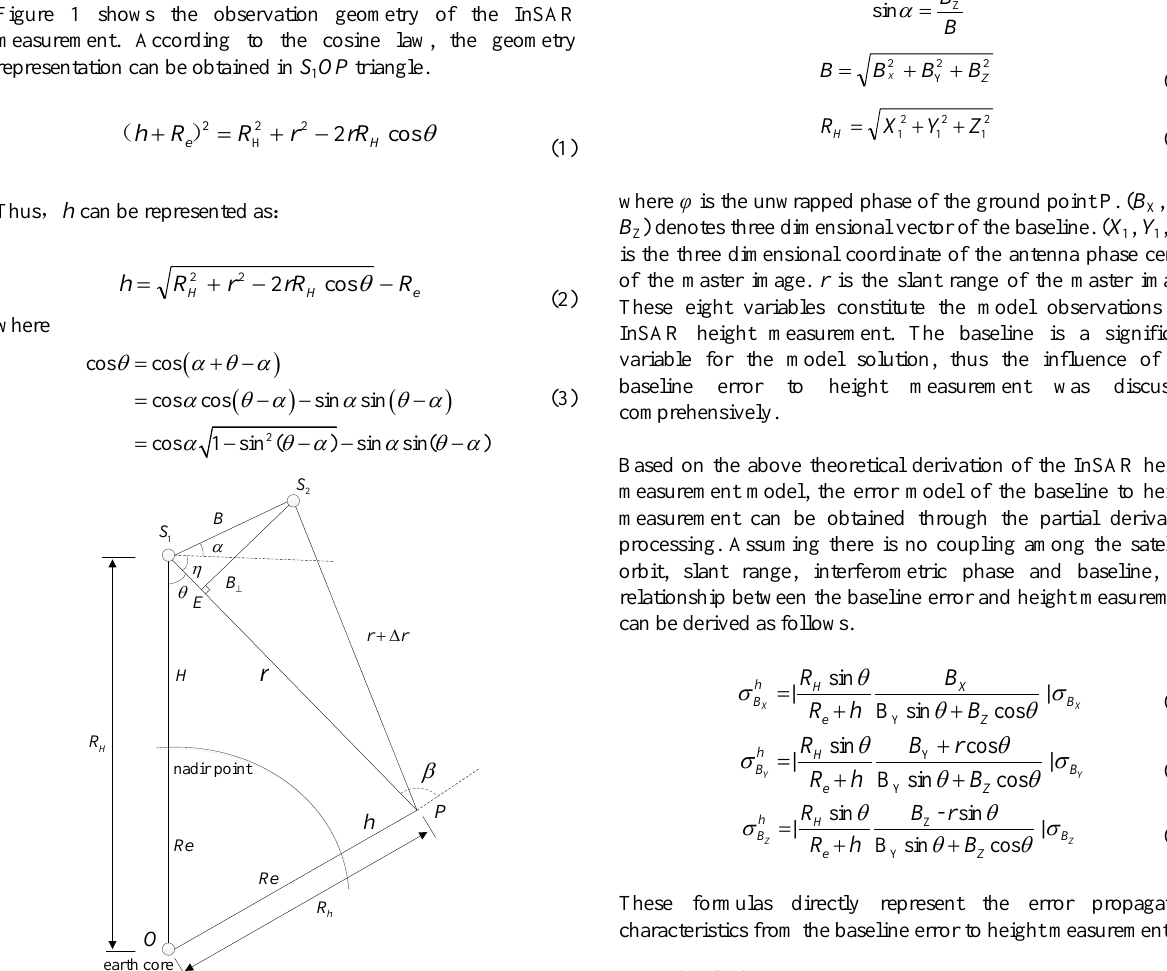
Figure 1. Observation geometry of the distributed